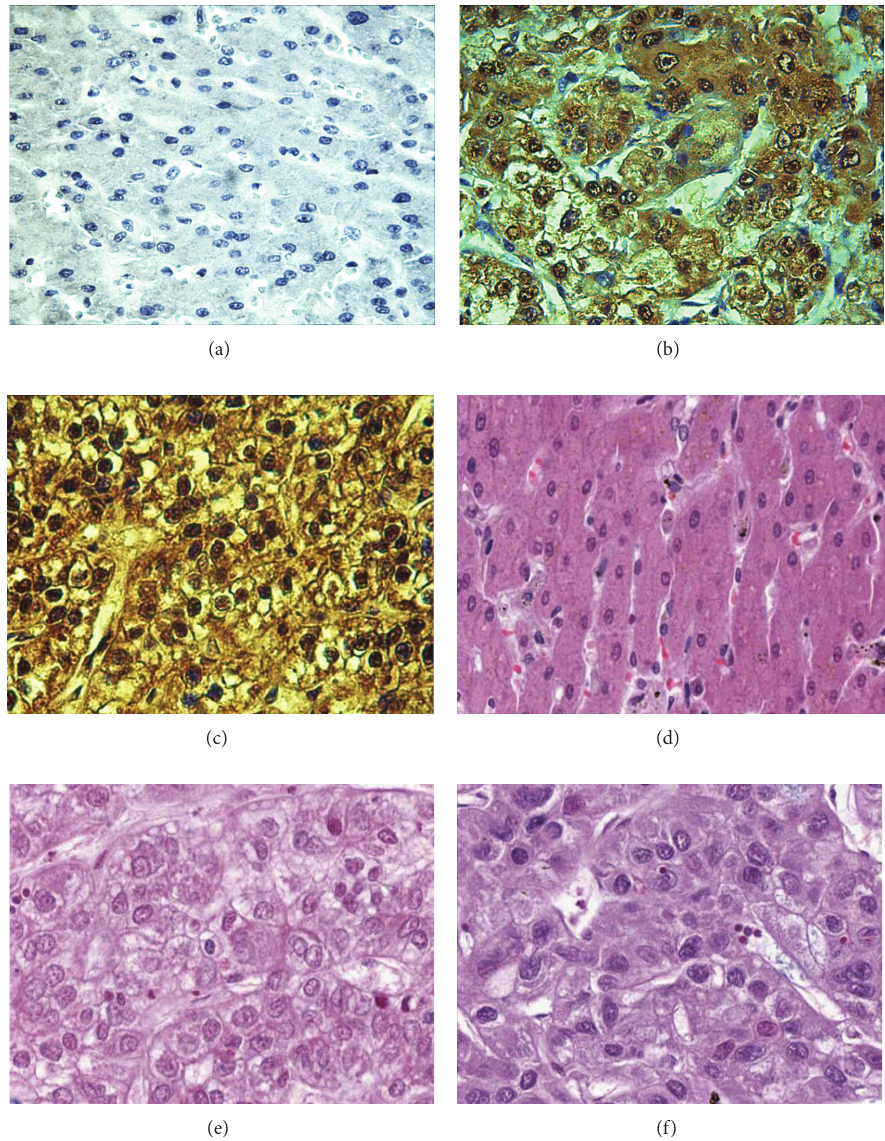
Figure 5: Expression of MDM2 in liver cancer and normal hepatic tissues by immunohistochemistry. The polyclonal anti-MDM2 antibody was used as primary antibody to detect the expression of MDM2 in liver cancer and normal hepatic tissues. (a) A normal hepatic tissue had negative staining; (b) HCC tissue (Grade II) had positive staining; (c) HCC tissue (Grade III) had positive staining; (d) a normal hepatic tissue with HE staining; (e) HCC tissue (Grade II) with HE staining; (f) HCC tissue (Grade III) with HE staining. Grade II: moderately differentiated, cells appear slightly different from normal. Grade III: poorly differentiated, cells appear abnormal and tend to grow and spread more